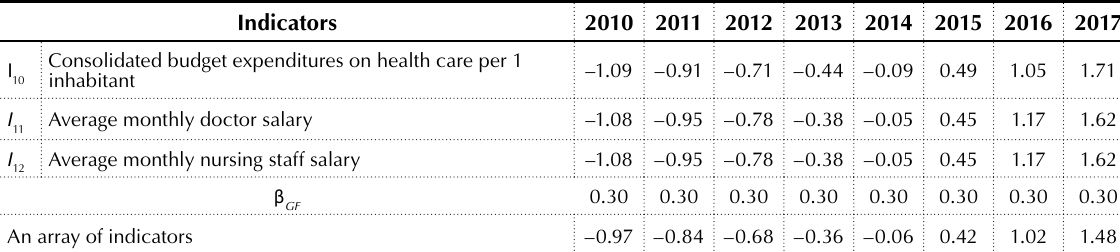
Table 6. Calculation of the socio-economic potential of health insurance/an array of indicators of the public financial resource management of socio-economic potential (specified